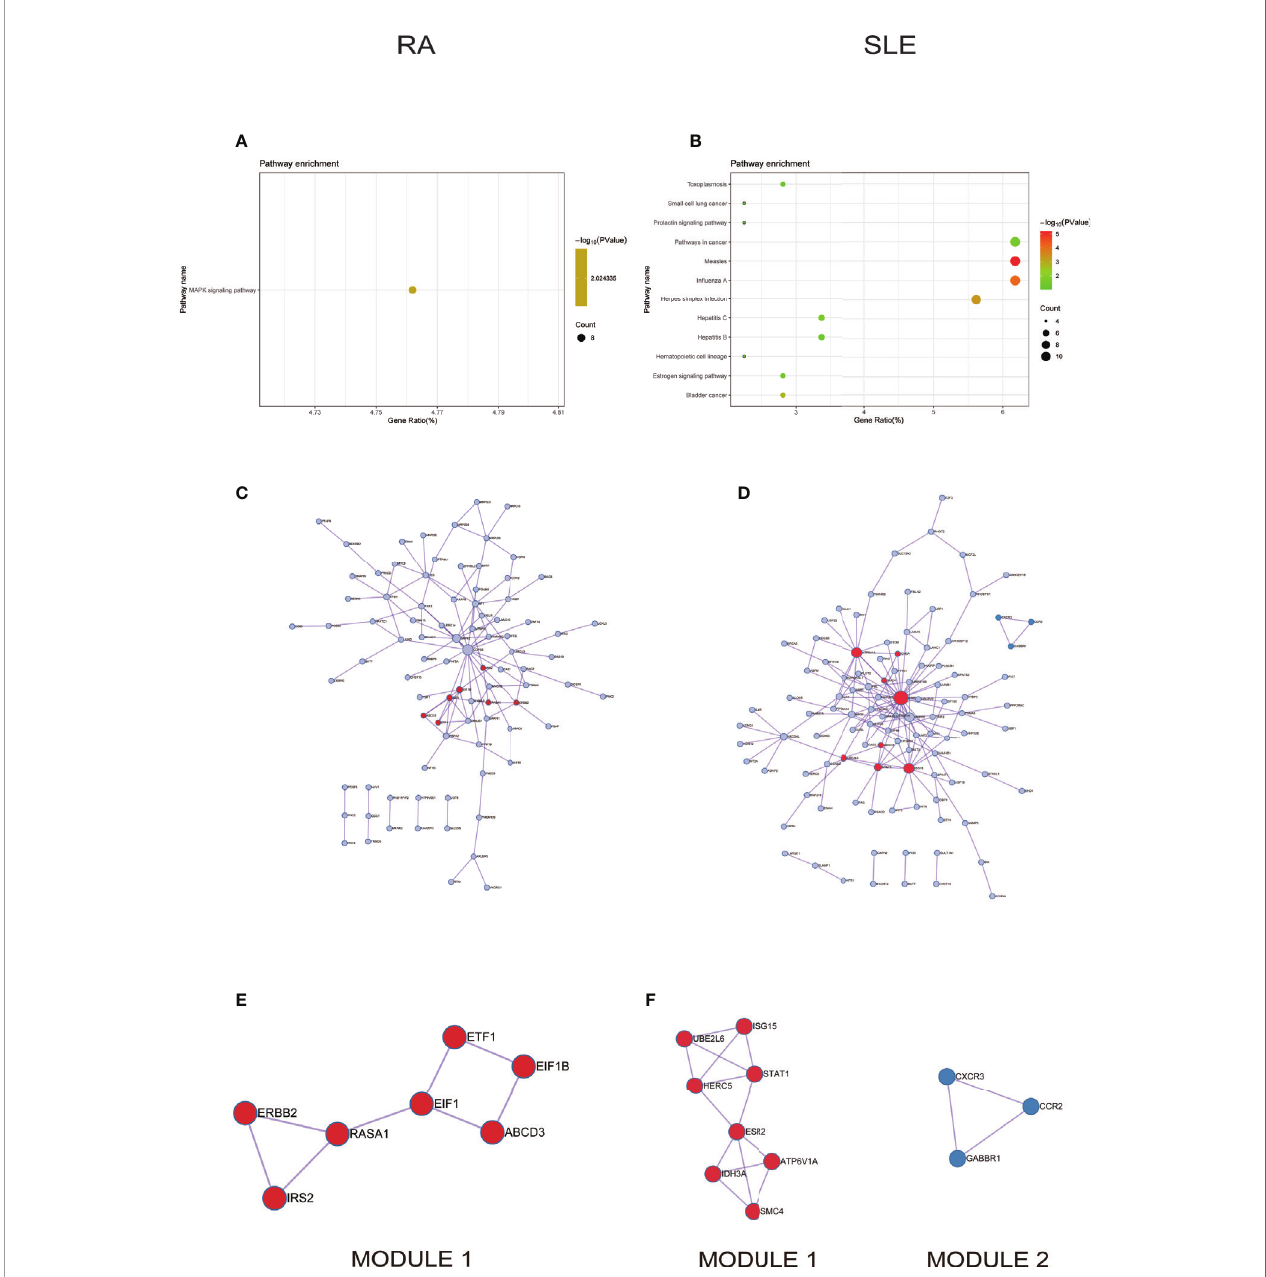
FIGURE 4 | The KEGG pathway analysis, PPI network and the most signi fi cant modules between RA and SLE in CD19 + B cells. (A, B) The KEGG pathway analysis of RA and SLE; (C, D) PPI network of CD19 + B cells analyzed by String software between RA and SLE; (E, F) The signi fi cant modules of CD19 + B cells identi fi ed by MCODE between RA and SLE. DEG, differentially expressed gene; PPI, protein-protein